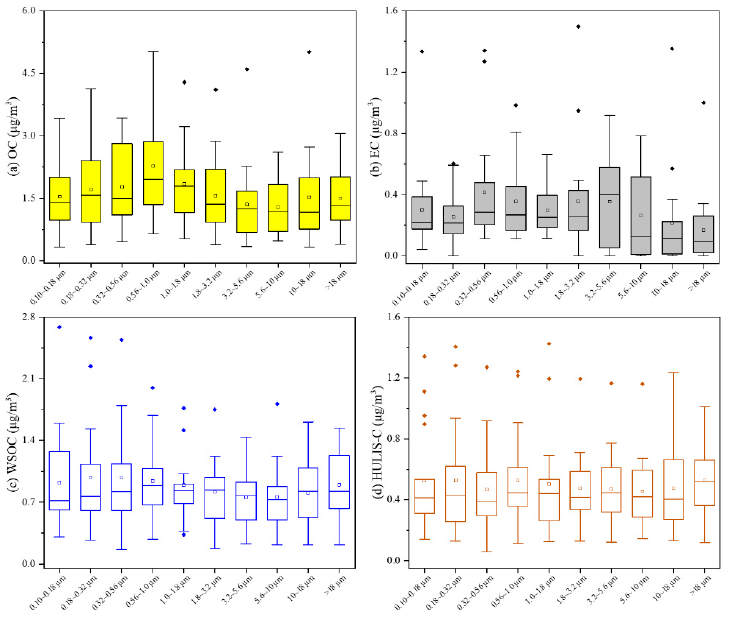
Figure 3. Size distribution of OC ( a ), EC ( b ), WSOC ( c ) and HULIS-C ( d ) in the aerosol samples through the whole year.